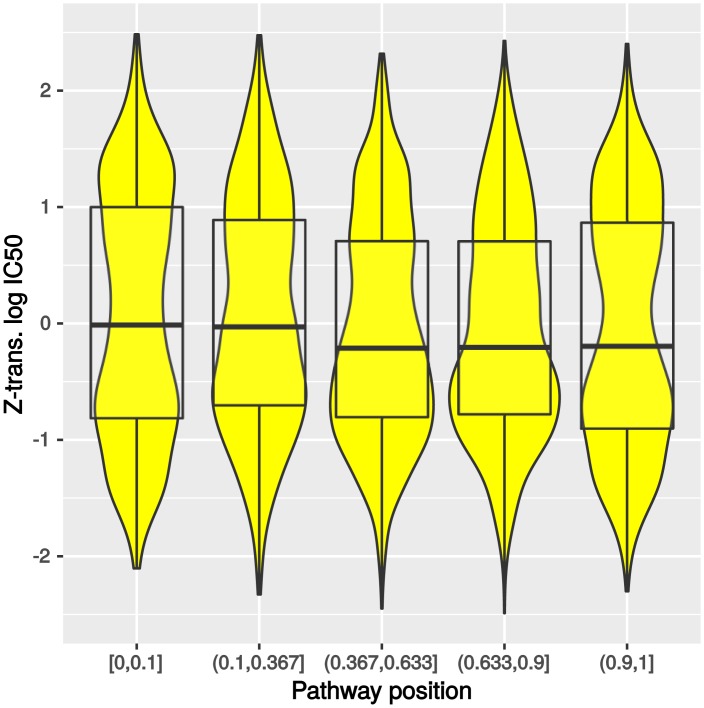
Distribution of intermediate toxicity for each pathway interval of all compounds listed in metacyc (lower values indicate higher toxicity).